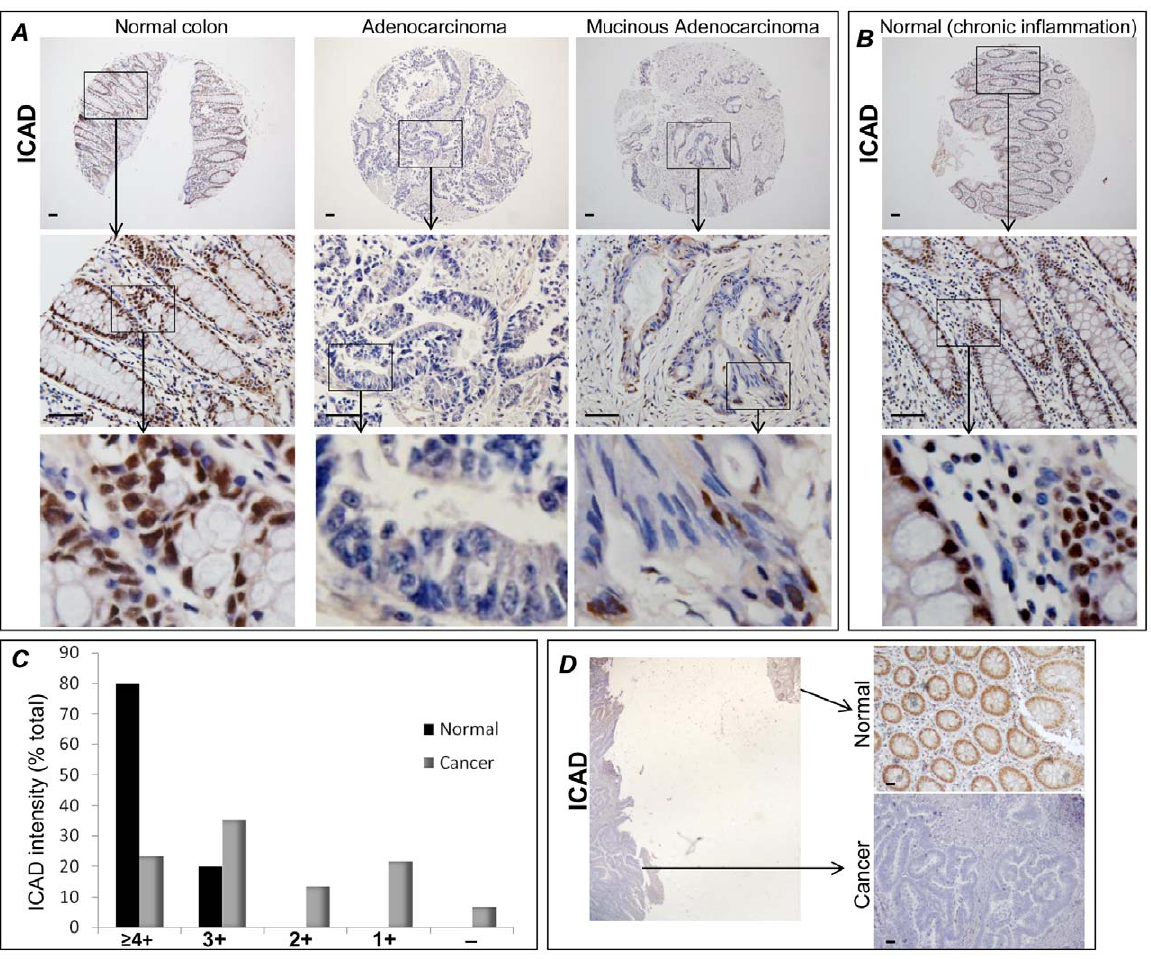
Figure 1. Association between ICAD deficiency and colon malignancy in humans. ( A ) Tissue arrays containing sections from normal colon (n=60) or cancer (n=131) tissues were subjected to immunohistochemical staining with antibodies against human ICAD. ( B ) Expression levels of ICAD in chronically inflamed colon. ( C ) The extent of ICAD immunoreactivity was assessed and classified as high ( $ 4 + ), moderate/high (3 + ), moderate/low (2 + ), low (1 + ), or negative ( 2 ); The results are expressed as percent positivity of total samples (cancer or normal). ( D ) Normal and cancerous tissues were fixed in formalin, embedded (both normal and diseased tissues from each patients were embedded together), sectioned, and then subjected to IHC with antibodies to human ICAD. Black boxes in ( A , B , and D ) indicate the magnified regions.